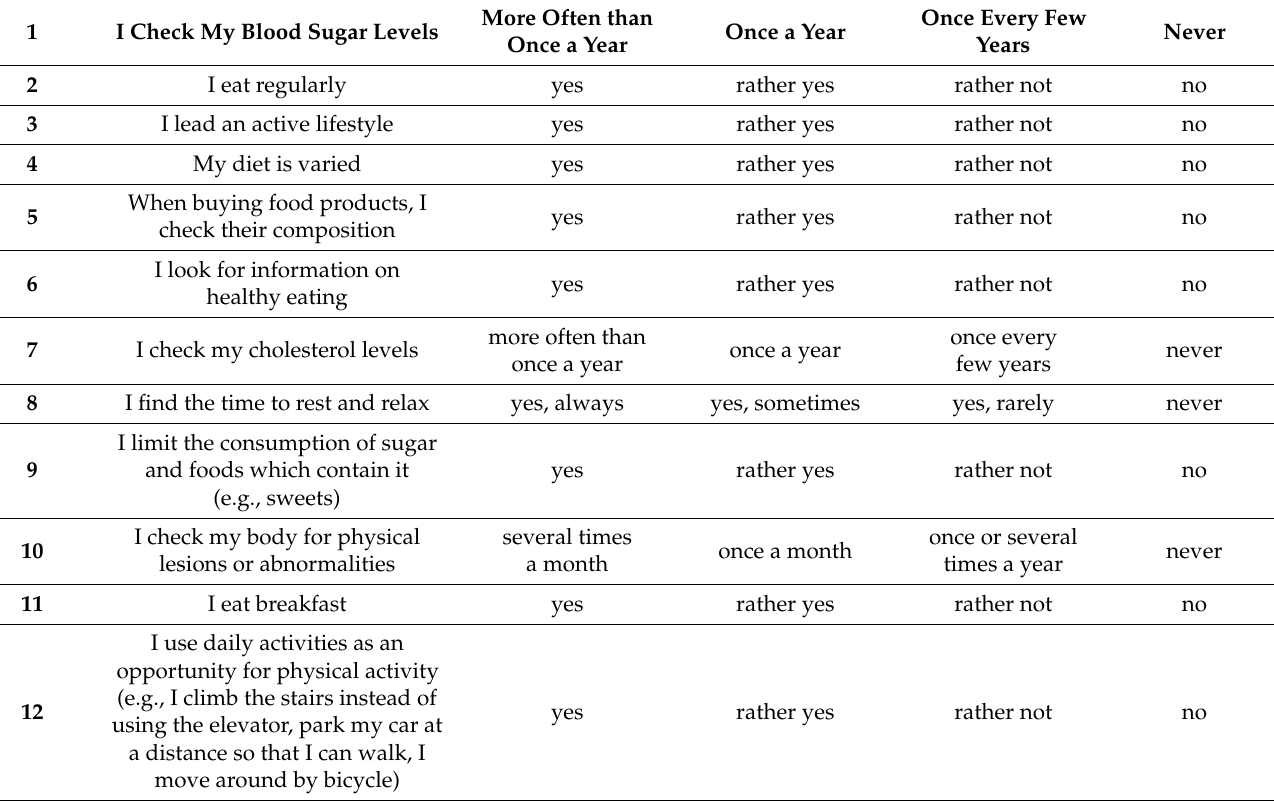
Table A1. English version of Health Behaviour Scale-16. The following table provides examples of various health-related behaviours and their frequency. Circle the answer which is right for you. The questionnaire is anonymous. Be sure to provide true